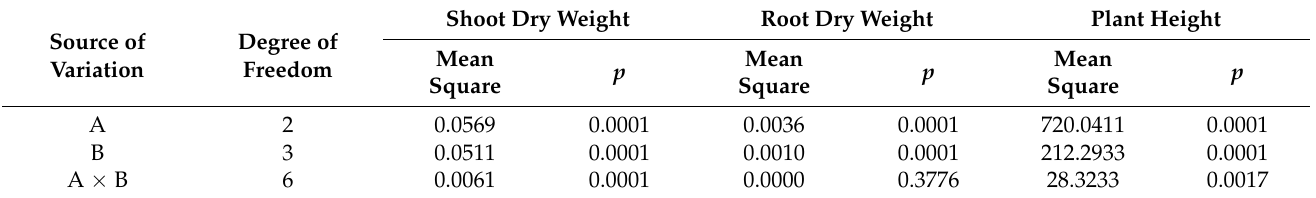
Table 1. Analysis of variance of Mn deficiency on dry weight and plant height of maize seedlings of different genotypes.